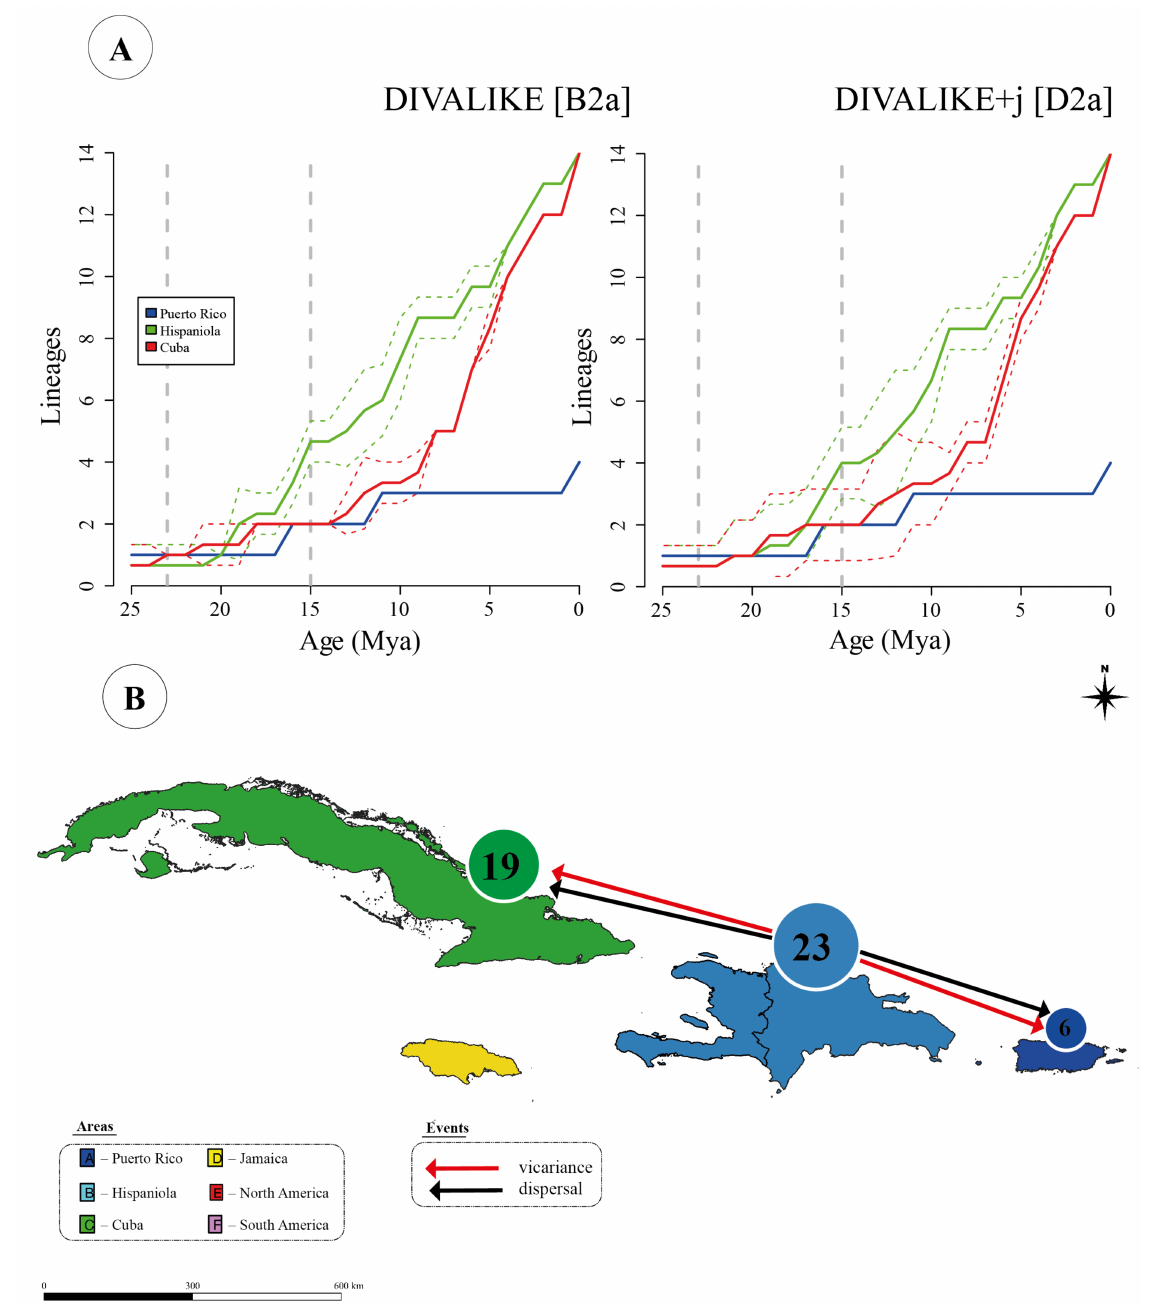
Figure 7. ( A ) Number of lineages occupying each area through time estimates under DIVALIKE and DIVALIKE +j and ( B ) the ancestral range. ( A ) Colored solid lines are the average of 100 biogeographic stochastic maps. Colored dashed lines are the 95% confidence interval. Gray dashed vertical line indicates the boundary between time slices in the time-stratified analysis. ( B ) Black arrows represent all dispersal events between areas. Red arrows represent a vicariance event between areas. Numbered circles indicate the inferred number of within-area speciation in each of the